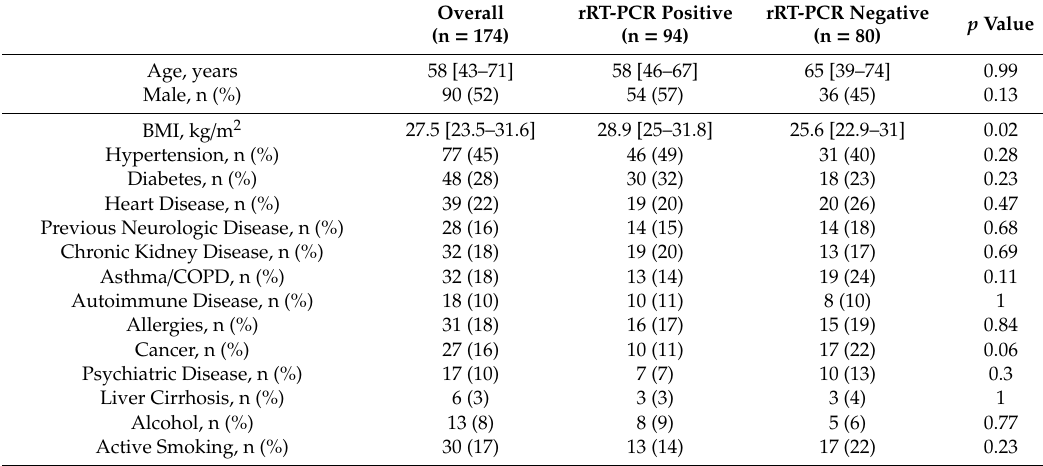
Table 1. Characteristics of the study population, according to rRT-PCR results on